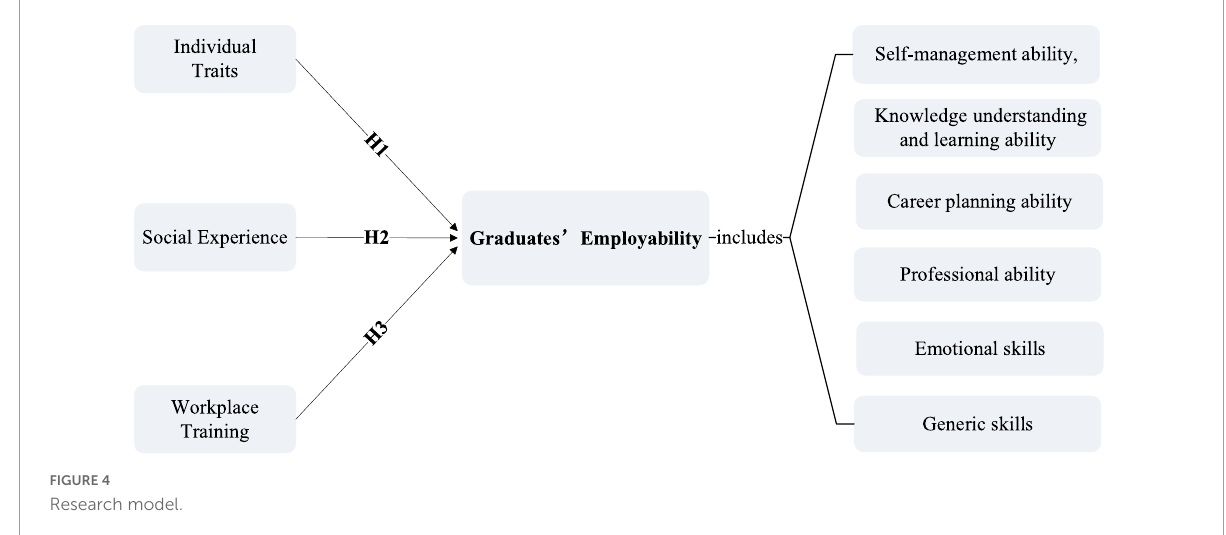
FIGURE4 Research